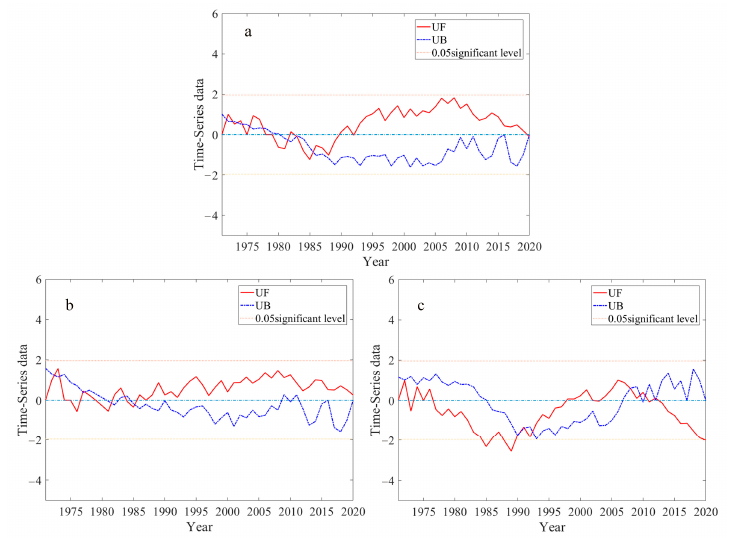
Figure 4 . Change points of the frequency of spring frost in the ( a ) entire Xinjiang, ( b ) Northern Xinjiang, and ( c ) Southern Xinjiang.